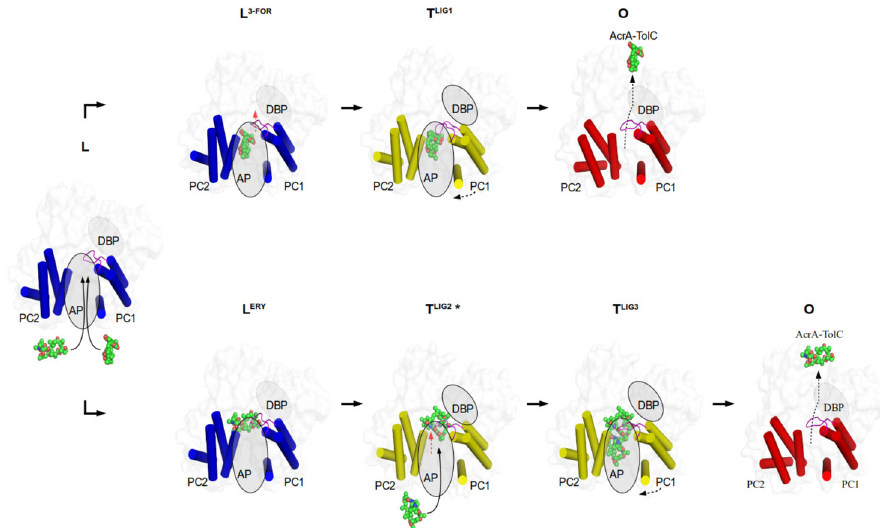
Fig. 5 Proposed transport mechanism for HMW drugs bypassing the DBP. Top view on the AcrB porter domain. Only the α -helical part of the PC1 and PC2 subdomains is shown (blue, L protomer; yellow, T protomer, red, O protomer). Binding of rifampicin-type (top row) and rifabutin/macrolide-type (bottom row) drugs to the access pocket (AP) is shown from left to right. The switch loop is colored in magenta. The dotted boundary of the ovals represents a closed deep binding pocket (DBP). Red arrow: the movement of switch loop. For further discussion on the mechanism see main text and Supplementary Note 2.5. PDB IDs of the displayed protomer structures: L, O: 4DX5; L 3-FOR : 6ZOB; L ERY : 6ZOC; T LIG1 : 6ZO7; T LIG2* , T LIG3 :